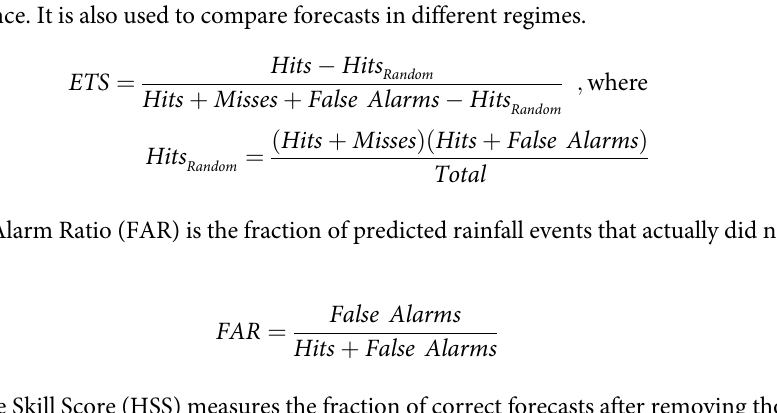
Accuracy is the fraction of correct forecasts by the model. This metric is heavily affected by the dominating class (e.g. no precipitation).